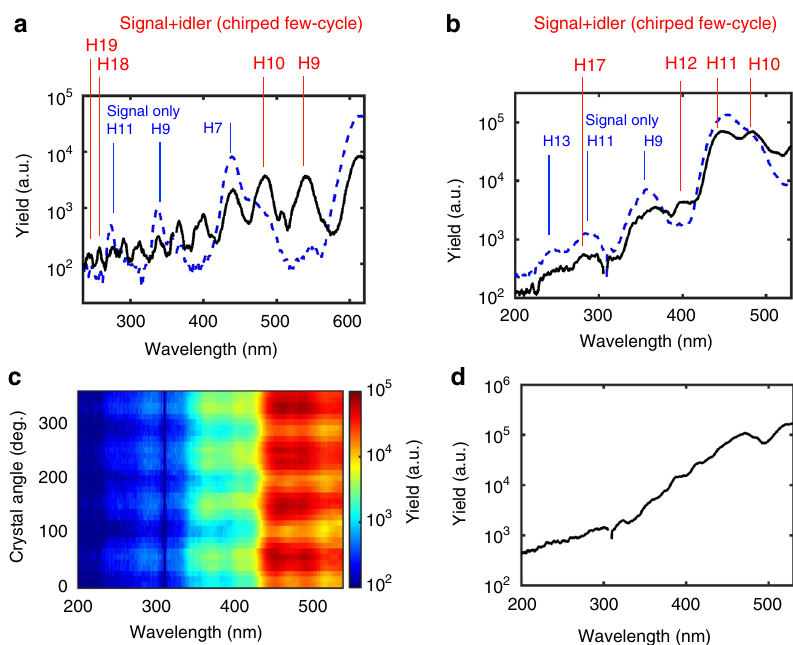
Fig. 6 Mid-infrared-driven high-harmonic generation in silicon samples. a Harmonic spectra generated in a 200-nm-thick free-standing silicon (Si) sample. The solid black line represents the spectrum generated by a chirped, ~43 fs, synthesised pulse, where the odd and even harmonics up to 19th order are observed. The blue dotted line represents the spectrum generated by only the signal pulse, where only odd harmonics up to 11th order are observed. b – d Harmonic spectra generated in a 500-nm-thick Si sample on a 0.5-mm-thick sapphire substrate. b The solid black line represents the spectrum generated by a chirped, ~43 fs, synthesised pulse, where the odd and even harmonics up to 17th order are observed. The blue dotted line represents the spectrum generated by only the signal pulse, where only odd harmonics up to 13th order are observed. c The angle dependence of the harmonic spectra about the Si axis < 001 > relative to the laser polarisation. The four-fold symmetry con fi rms that the harmonic spectra originate from HHG in Si. The high-harmonic generation (HHG) yield is maximised when laser polarisation is along < 011 > . d The near-continuous harmonic spectrum generated by the synthesised sub-cycle pulse without chirping. The harmonic comb structure is almost washed out due to the isolated emission from